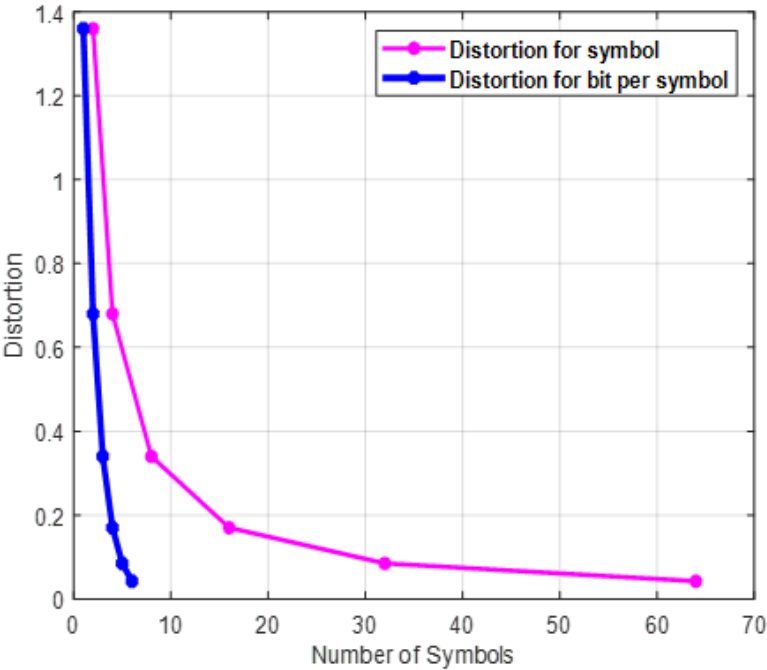
Figure 2. Distortion versus number of symbols with k = 5 or 10 and M = 64.